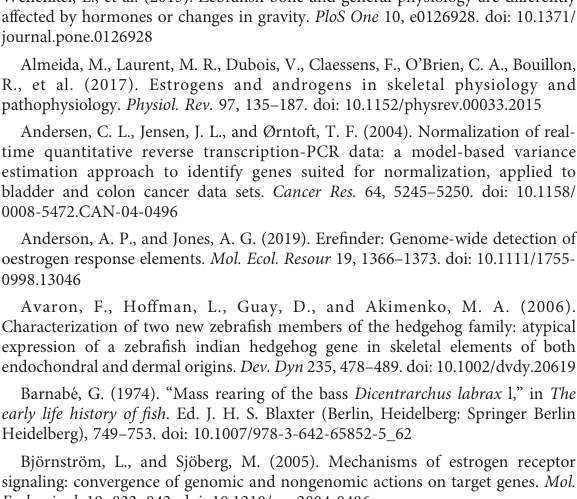
SUPPLEMENTARY FIGURE 2 Quanti fi cation of the level of head mineralization from alizarin red staining: comparison between a TS larva versus an E2 40-treated larva of the same size. For each larva, the picture of its stained head and the corresponding mineralization score table are given as an example, to illustrate the